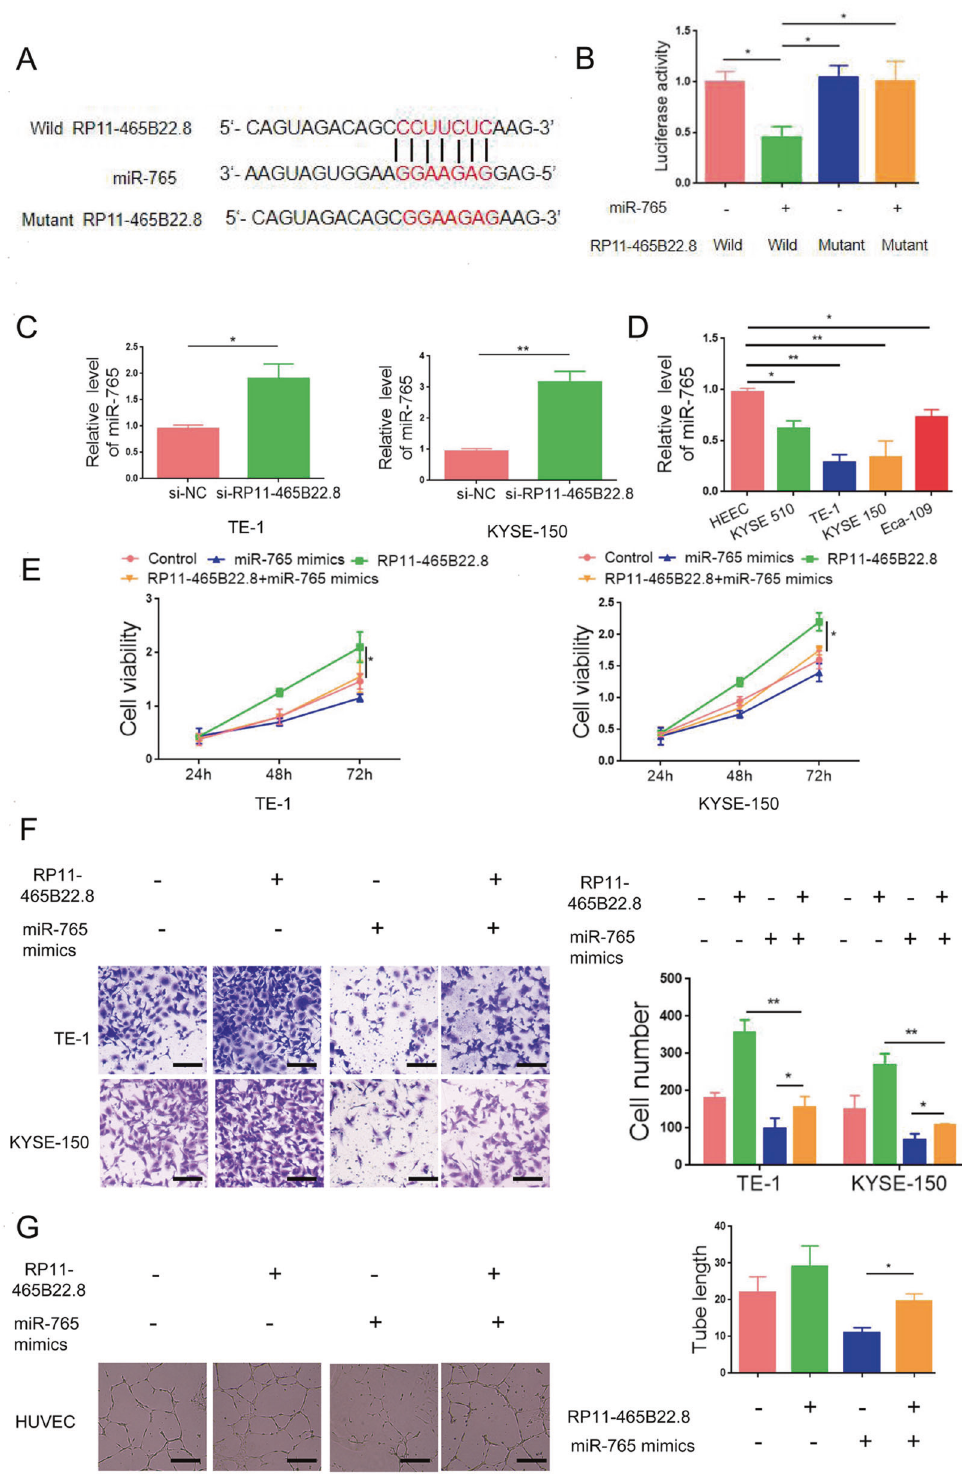
Fig. 4 LncRNA RP11-465B22.8 promotes EC cell viability and mobility by sponging miR-765. A The predicted binding sites of miR-765 in lncRNA RP11-465B22.8. B Luciferase reporter assay in HEK293T cells transfected with miR-765 together with the wildtype (wild) or mutated lncRNA RP11-465B22.8 (mutant). C qRT-PCR analysis miR-765 expression in EC cells with lncRNA RP11-465B22.8 knockdown. D qRT-PCR analysis of miR-765 expression in different EC cell lines. E Transfection of miR-765 mimics abolished the enhanced effect of lncRNA RP11- 465B22.8 on EC cell viability. F Transfection of miR-765 mimics abolished the enhanced effect of lncRNA RP11-465B22.8 on EC cell migration. G Transfection of miR-765 mimics abolished the promoting effect of conditioned medium from EC cells overexpressing lncRNA RP11-465B22.8 on the tube formation of HUVECs. * P < 0.05, ** P < 0.01.